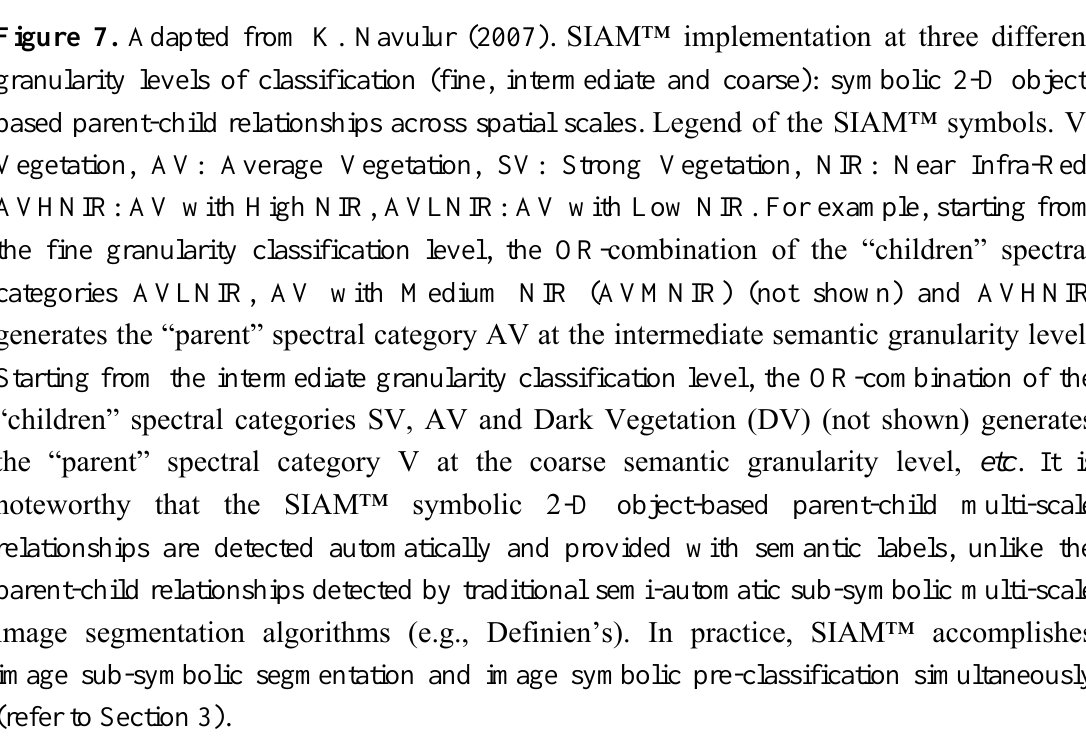
Symbolic super-segment at coarse semantic granularity